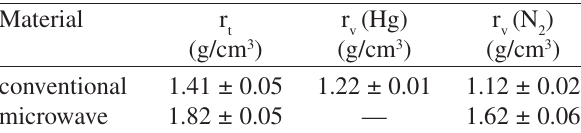
Table 1. Values of bulk density (r silica obtained via conventional heating and microwave heating.